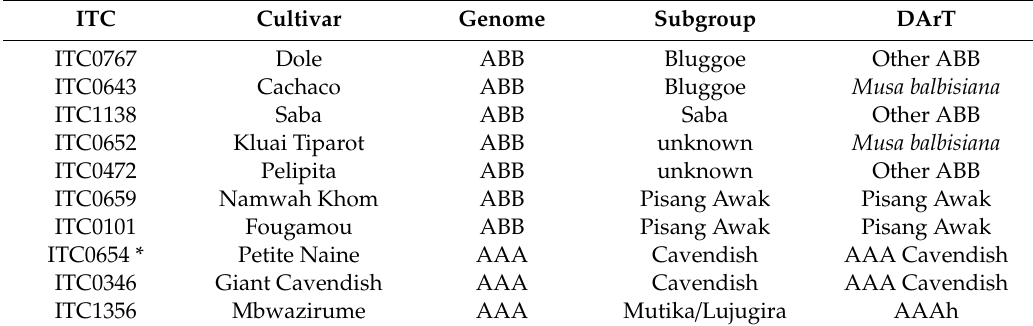
Table 1. List and characteristics of banana cultivars studied for antiviral